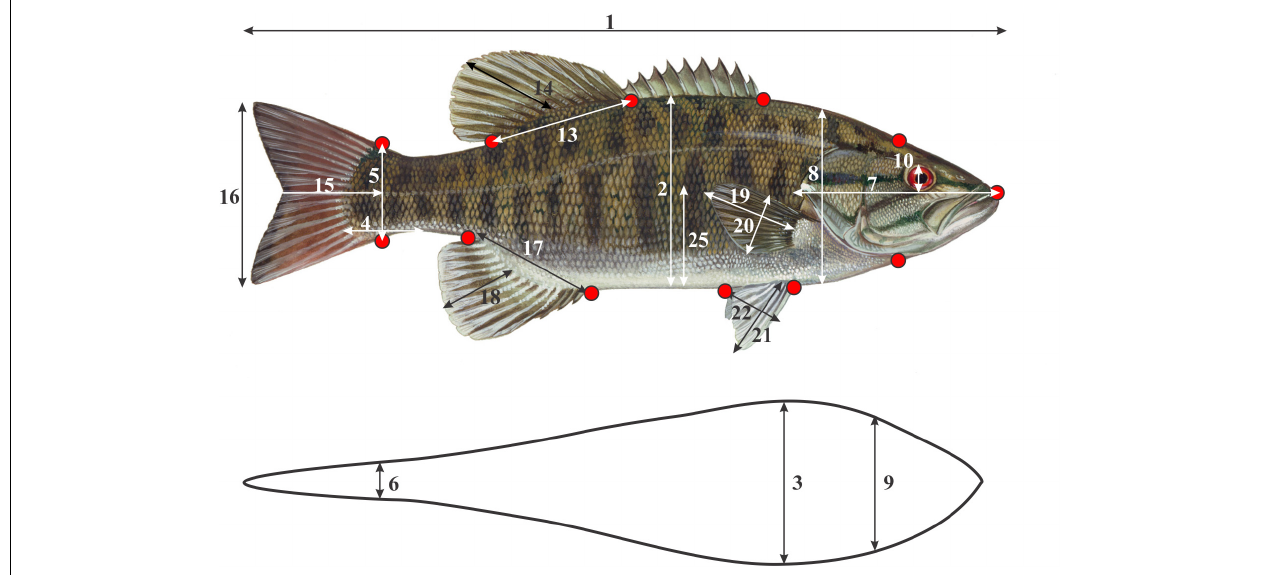
) and 21 of the 25 linear morphometric measurements taken for each specimen. The four linear FIGURE 2 | The 12 geometric morphometric landmark positions ( measurements associated with the mouth (mouth height – MoH, mouth width – MoW, Length of snout with mouth open – LSO and Length of snout with mouth (cid:32) closed – LSC, are not illustrated. Linear morphometric measurement numbers correspond to those in Table 1 .